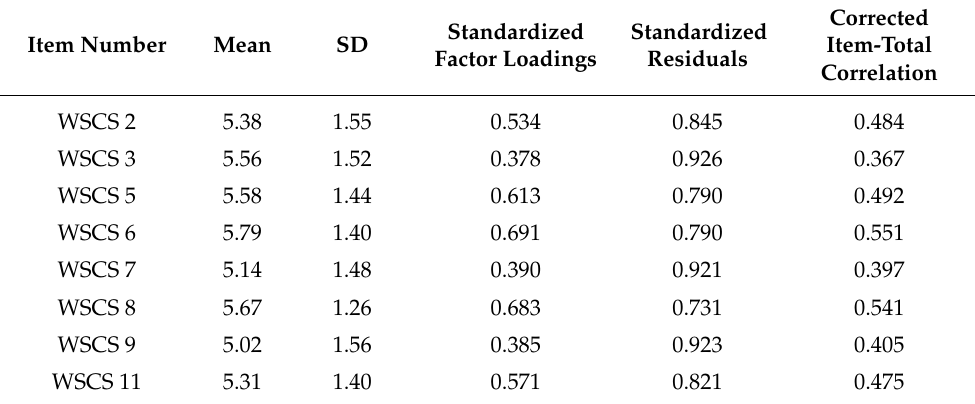
Table 1. WSCS item means, SD, standardized factor loadings, and corrected item-total correlations (Sample